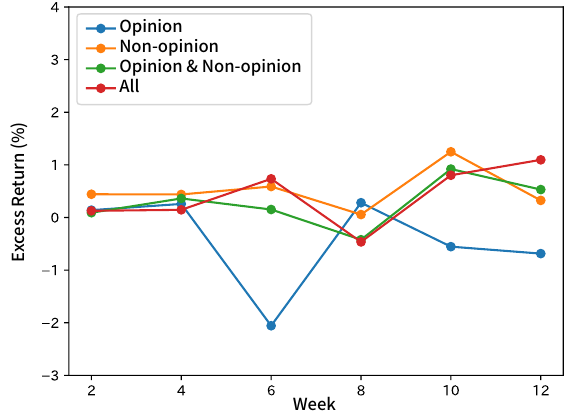
Figure 6. Excess returns of Broker C in forecasting analyst net income estimates.